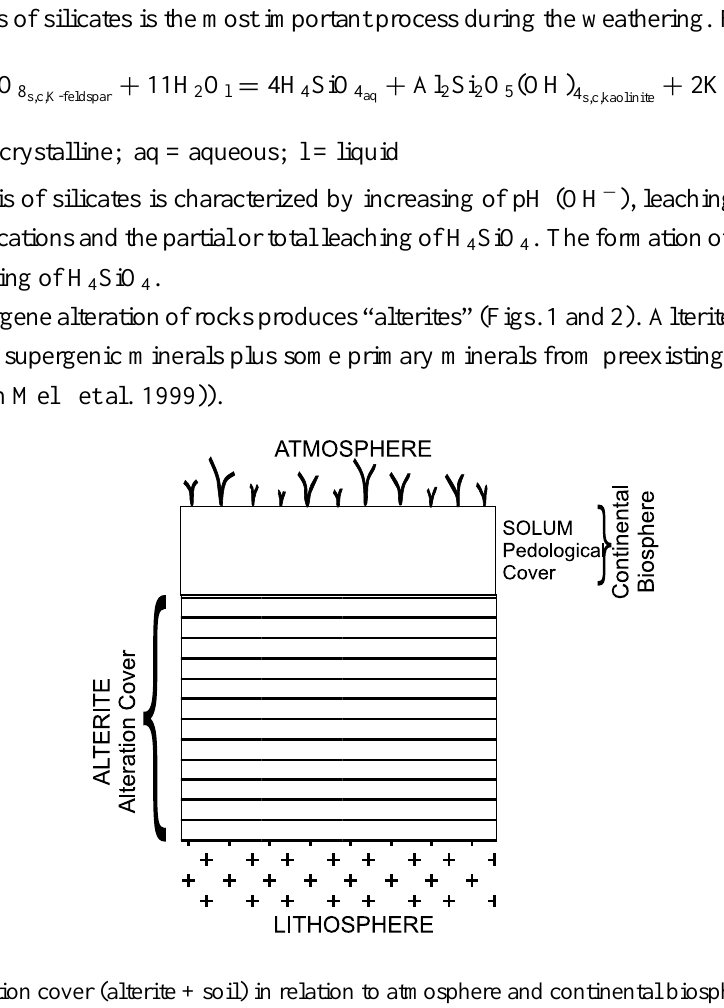
CHEMICAL WEATHERING OF